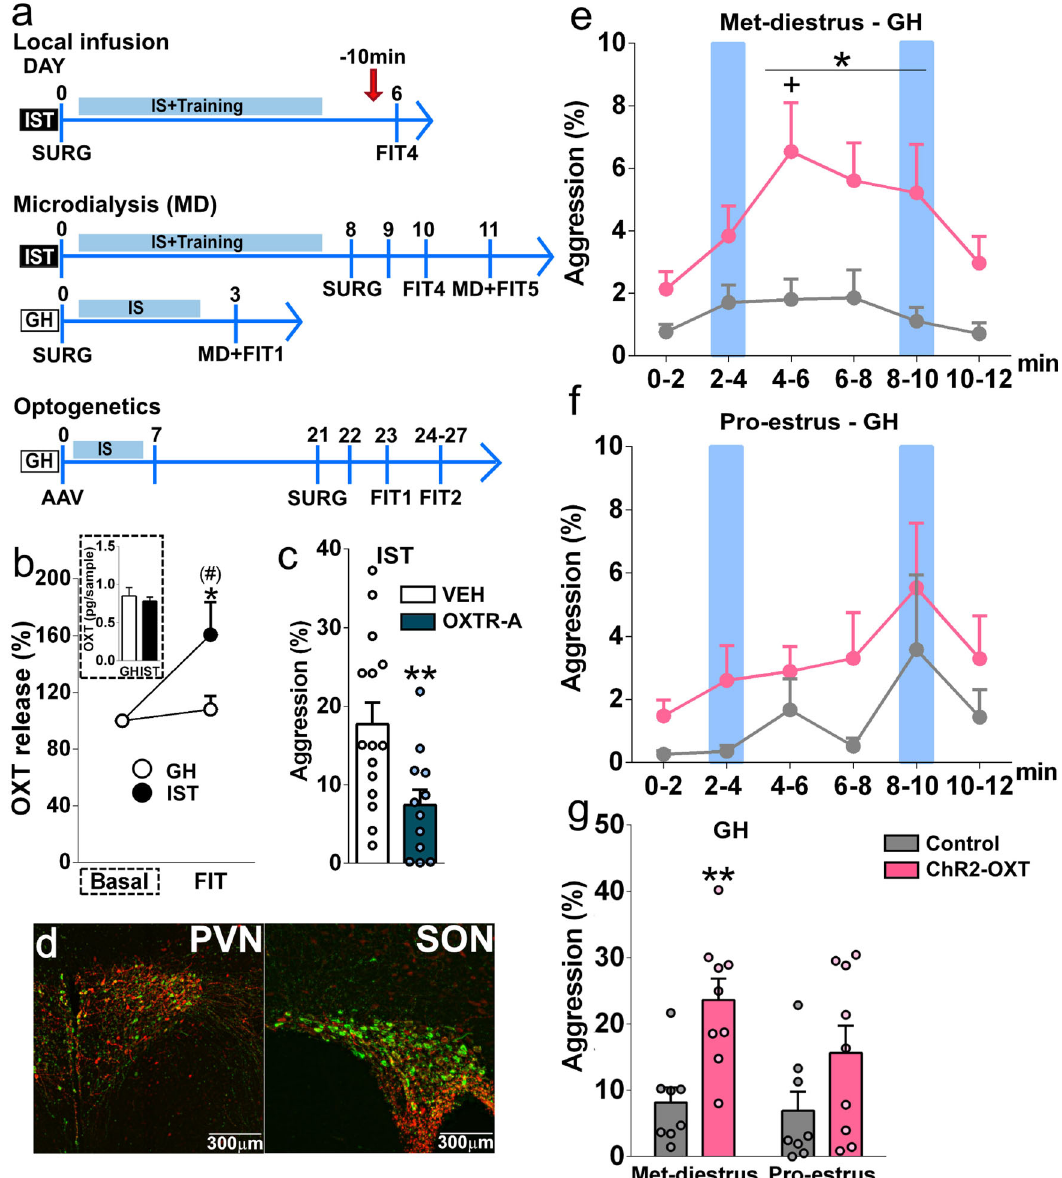
Fig. 4 The pro-aggressive effect of OXT is mediated in the vLS. a Scheme illustrating the experimental design for pharmacological, microdialysis, and optogenetic experiments targeting the OXT system ( AAV adeno-associated virus microinfusion into the hypothalamic paraventricular (PVN) and supraoptic (SON) nuclei; arrow = drug infusions; FIT female intruder test; GH group-housed; IS social isolation; IST isolated and trained, MD microdialysis, SURG surgery, OXT oxytocin, OXTR-A OXT receptor antagonist, vLS ventral part of the lateral septum). b IST, but not GH females showed an increased rise in the percentage of OXT release (OXT content in microdialysates sampled during the FIT/OXT content in microdialysates sampled in the baseline × 100) in the vLS during the FIT (one sample Student ’ s t test IST: t (7) = 2.65, p = 0.033; GH: t (7) = 0.83, p = 0.43), thus OXT release during FIT tended to be higher in IST compared with GH rats ( t (14) = 2.12, p = 0.053). Insert shows that absolute OXT content in microdialysates sampled under basal conditions did not differ between the groups ( t (14) = 0.54, p = 0.60). c OXTR-A (100 ng/0.5 µ l) infusion into the vLS reduced total aggression (two-tailed Student ’ s t test t (26) = 2.58, p = 0.016) in IST females. d – g Optogenetic stimulation (indicated by blue columns) of OXT axons in the vLS of GH females during the FIT. d Con fi rmation of virus infection in OXT neurons of the PVN (left) and SON (right). OXT-neurophysin I staining: green; mCherry (virus): red. Scale bars 300 µ m. Blue-light stimulation of channelrhodopsin (ChR2)-OXT fi bers enhanced aggressive behavior in e metestrus-diestrus (Met-diestrus) (two-way ANOVA followed by Bonferroni factor: time: F (5,75) = 2.72, p = 0.026; virus: F (5,75) = 20.03, p = 0.0004; time × virus: F (5,75) = 1.056, p = 0.392), but not in f proestrus-estrus (Pro-estrus) females (time: F (5,70) = 2.84, p = 0.02; factor virus: F (1,14) = 2.73, p = 0.12; virus × time: F (5,70) = 0.02, p = 0.97). g Cumulative analyses show that light stimulation enhanced aggression only in ChR2-OXT females in the metestrus-diestrus phase of the cycle (factor virus: F (1,15) = 13.06, p = 0.0026; estrous cycle: F (1,15) = 2.07, p = 0.17; virus × estrous cycle: F (1,15) = 1.114, p = 0.31). Data are shown as mean + SEM. (#) p = 0.05 vs GH; * p < 0.05, ** p < 0.01 vs either vehicle, baseline or ChR2 control; + p < 0.05 vs 0 – 2 time point. Microdialysis: n = 8; OXTR-A: n = 13 and 15; optogenetics: n = 8 and 9. Control group consisted of rAAV1/2 OXTpr-mCherry + light